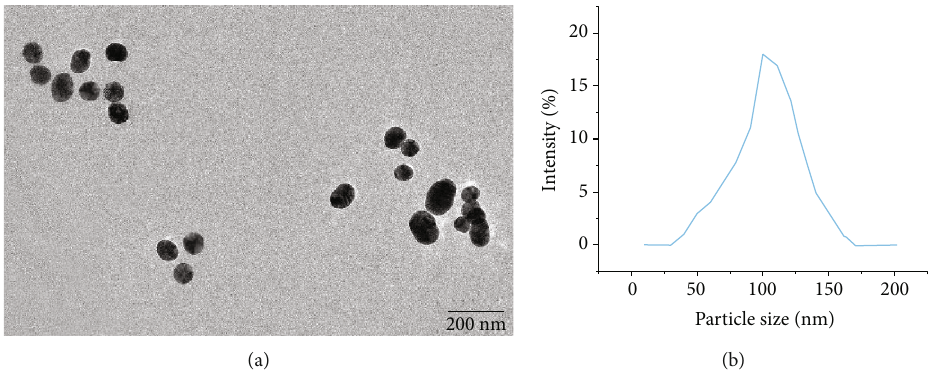
Figure 3: Characterization of TF-PEG-DSPE/DOX NPs. (a) Transmission electron microscopy (TEM) image of TF-PEG-DSPE/DOX NPs. (b) Particle size distribution chart of TF-PEG-DSPE/DOX NPs.